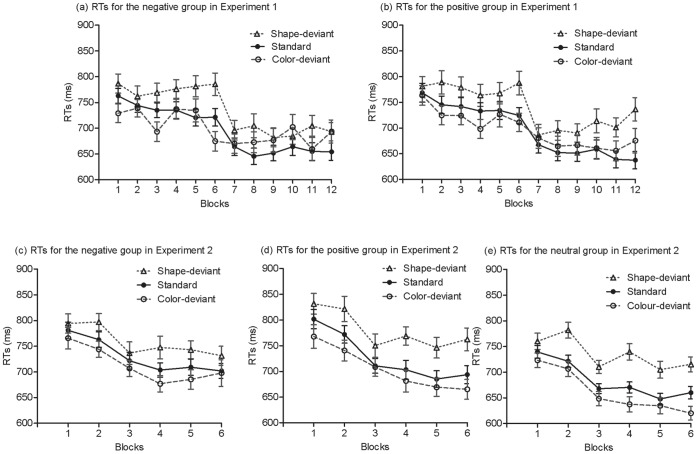
Mean reaction times for shape-deviant, standard, and color-deviant stimuli across training blocks in Experiments 1 and 2.Error bars depict standard errors.